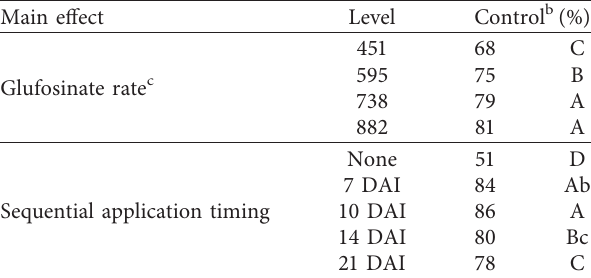
Table 3: Palmer amaranth control 3 weeks after the final appli- cation for the main effects of glufosinate rate and sequential ap- plication timing, averaged over the other factors in Fayetteville, AR, in 2015, 2016, and